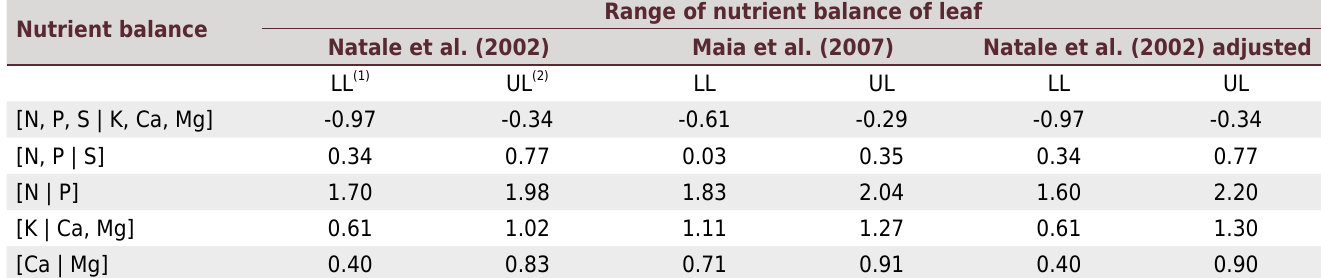
Figure 4. Seasonal variation in nutrient balance of ‘Paluma’ guava during the trial period. Vertical bars at each point represent the standard error of the mean. Arrows are the ranges of nutrient balances calculated from Natale et al. (2002) (dashed lines) and Maia et al. (2007) (solid Table 3. Range of nutrient balances obtained by standard nutrient content indicated by literature Nutrient balance